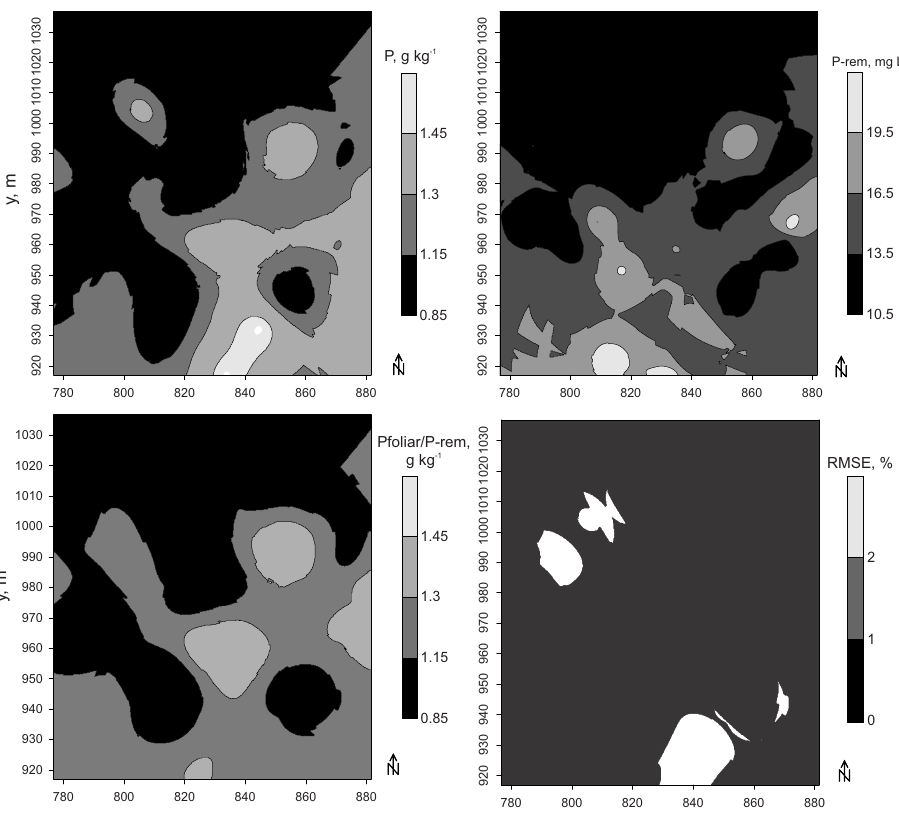
Figure 2. Spatial distribution maps obtained by ordinary kriging (foliar P and P-rem), cokriging (Pfoliar/P- rem) and root mean square error (RMSE) for Coffea arabica L. cv Catucai.